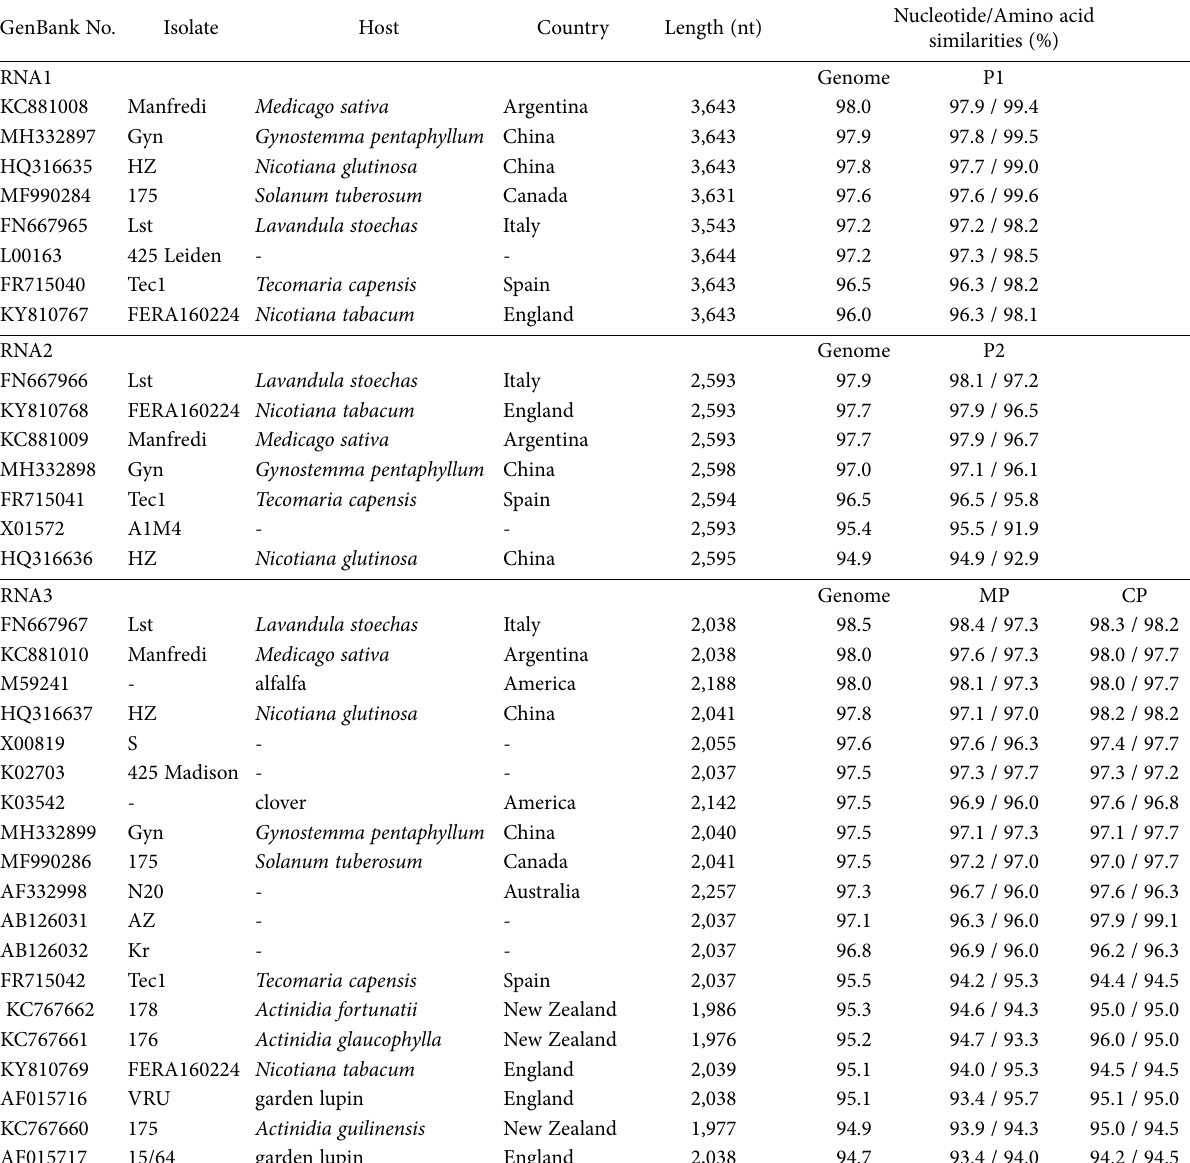
Table 1. Nucleotide and amino acid sequence similarities between AMV-Mint and other AMV isolates. GenBank